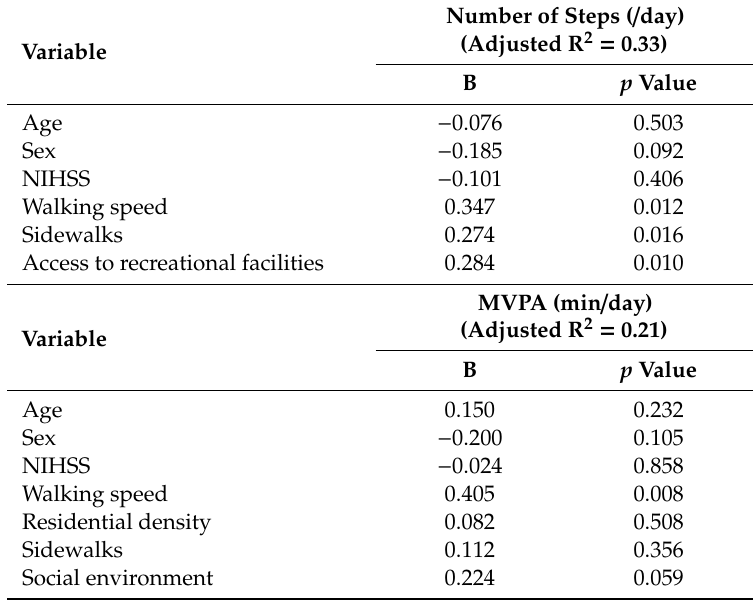
Table 2. Multivariate regression analysis for physical activity